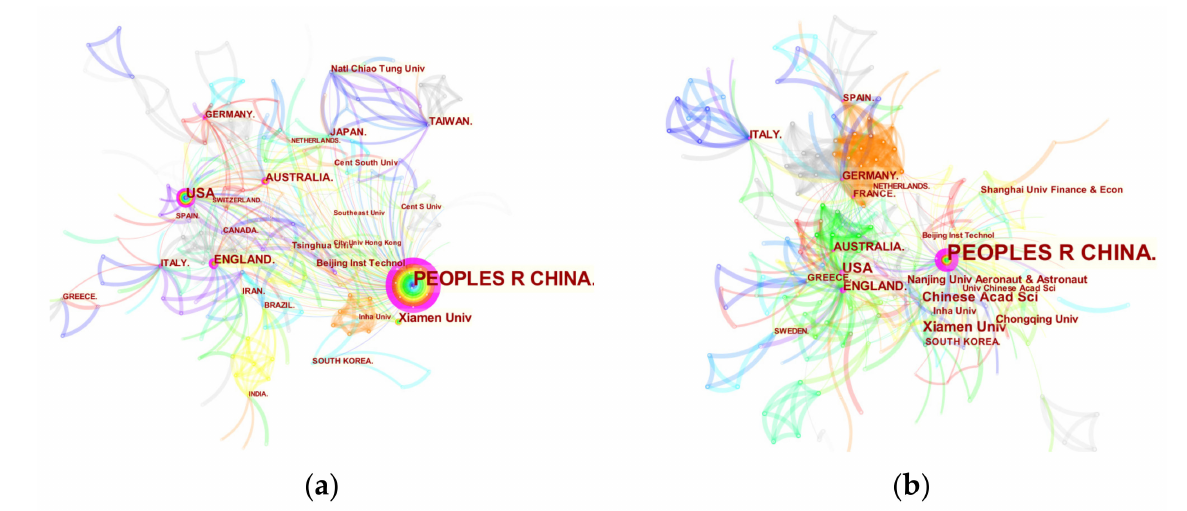
Figure 2. Map of national and institutional collaboration networks of TFEE ( a ) and TFCE ( b